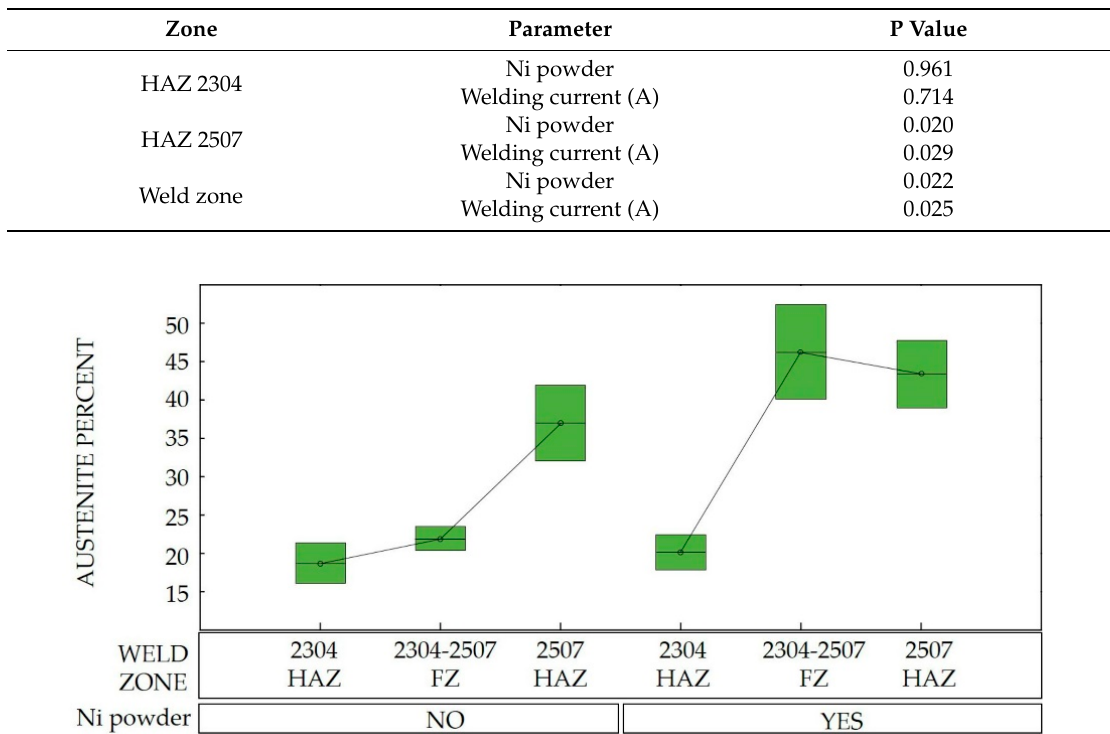
Figure 2. Box plot for austenite percentage. FZ: fusion zone; HAZ: heat-affected zone.